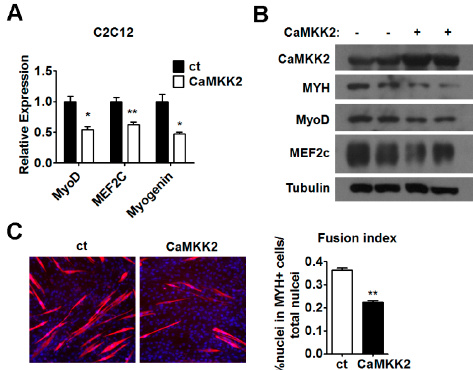
Figure 3. CaMKK2 inhibits C2C12 myoblasts differentiation. ( A ) Quantitative RT-PCR analysis of MyoD, MEF2c and Myogenin mRNA levels in C2C12 myotubes transfected with CaMKK2 plasmids ( n = 3); ( B ) Representative western blot showing the MYH, MyoD and MEF2c protein levels in C2C12 myotubes transfected with CaMKK2 plasmids; and ( C ) Immunofluorescence analysis of MYH was performed in C2C12 myotubes 48 h after CaMKK2 plasmids transfection ( left ), quantification of the fusion index of indicated cells ( right ) ( n = 3). Experiments were repeated at least twice. Means ± SEM (error bars) are shown. *, p < 0.05; **, p < 0.01.